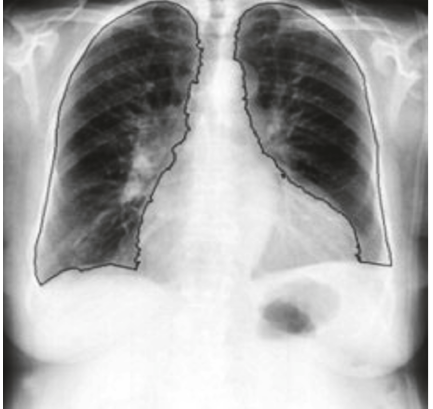
Figure 3: Segmented